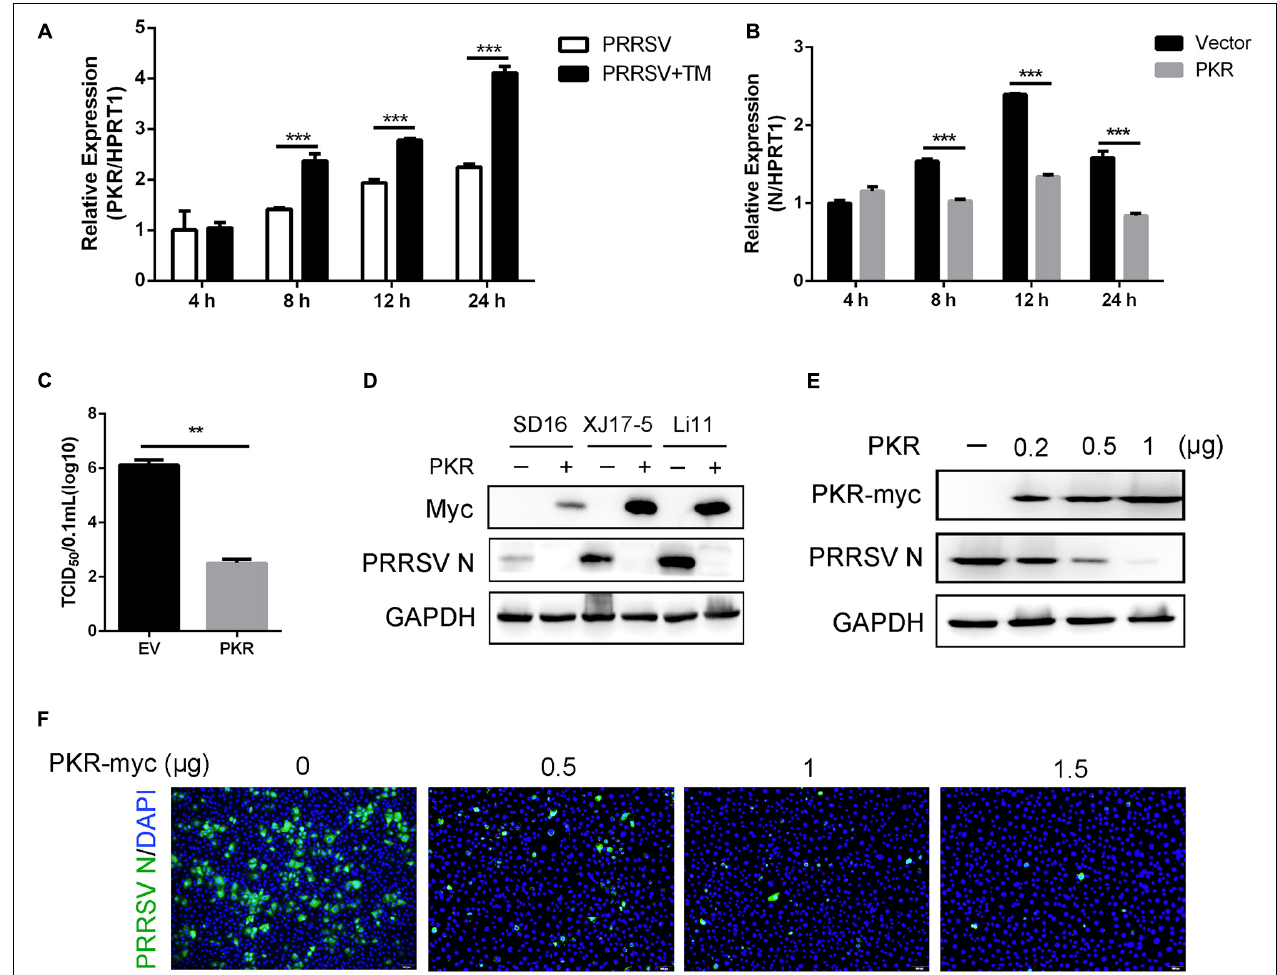
FIGURE 4 | Overexpression of PKR inhibits the replication of PRRSV. (A) Marc-145 cells were infected with PRRSV (MOI = 1) in the presence or absence of TM (1 µ g/ml) for 4, 8, 12, and 24 hpi. The mRNA expression of PKR was shown, as detected by qRT-PCR. (B) Marc-145 cells were transfected with pcDNA3.1-control (vector) or pcDNA3.1-PKR for 24 h and then infected with PRRSV (MOI = 1) for the indicated time (4, 8, 12, and 24 hpi). PAMs were collected, and the transcription levels of PRRSV N were shown using qRT-PCR. (C) Marc-145 cells were transfected with an empty vector or PKR. After overexpression for 24 h, cells were infected with PRRSV (MOI = 1) for 24 h. TCID 50 is shown from cell supernatants. (D) pcDNA3.1-control plasmid and pcDNA3.1-PKR plasmid were transfected into Marc-145 cells for 24 h, and cells were infected with different strains of PRRSV (SD16, XJ17-5, and Li11, MOI = 1) for another 24 h. The expression of Myc and PRRSV N was shown, as measured by Western blot analysis. (E,F) Marc-145 cells were transfected with different concentrations of pcDNA3.1-PKR plasmid (0, 0.2, 0.5, 1 µ g) for 24 h, and then cells were infected with PRRSV (MOI = 1). Western blot was used to detect the expression of Myc, PRRSV N, and GAPDH. GAPDH is shown as an internal control (E) . Immunofluorescence analysis of PRRSV N (green) expression in Marc-145 cells. Nuclei were counterstained with DAPI (blue). Bar = 200 µ m (F) . Data are the results of three independent experiments (means ± SE). Significant differences are denoted by * p < 0.05, ** p < 0.01, and *** p <